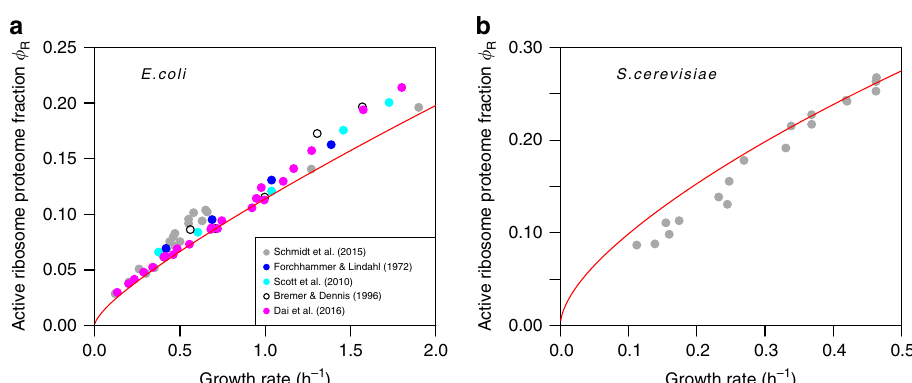
Fig. 2 GBA predictions of active ribosomal proteome fractions agree with experimental estimates. Comparison of GBA predictions (red lines, no free parameters) and data. a Ribosomal proteome fractions for E. coli across different growth conditions, estimated from quantitative proteomics 45 and total RNA/protein ratios 19,42,46,66 ( N = 58; Pearson's correlation coef fi cient between observed and predicted values r 2 = 0.97, P < 10 − 43 ; coef fi cient of determination R 2 = 0.91, i.e., the variance of the residuals is only 9% of the variance of the raw data). b Ribosomal proteome fractions for S. cerevisiae across different growth conditions from quantitative proteomics 47 ( N = 18; r 2 = 0.98, P < 10 − 14 ; R 2 ϕ ≡ p μ , j j / P facilitated by the increase in x i at constant